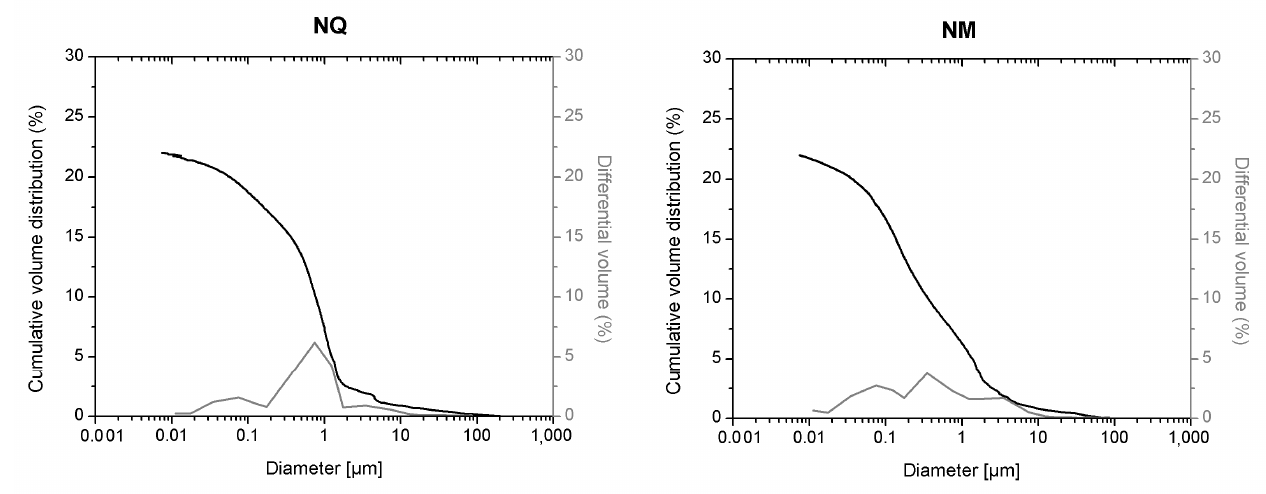
Figure 2. MIP cumulative volume distribution (black) and differential volume (gray) of samples with natural hydraulic lime (NQ, left , and NM, right ).